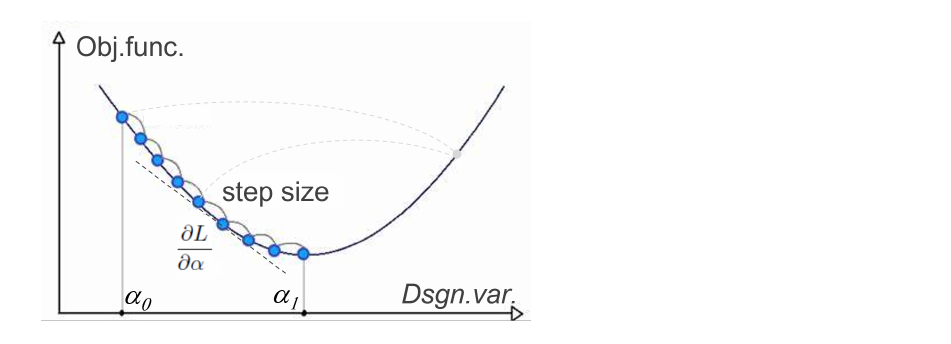
Figure 2. General principle of the design variable update based on steepest gradient descent method.